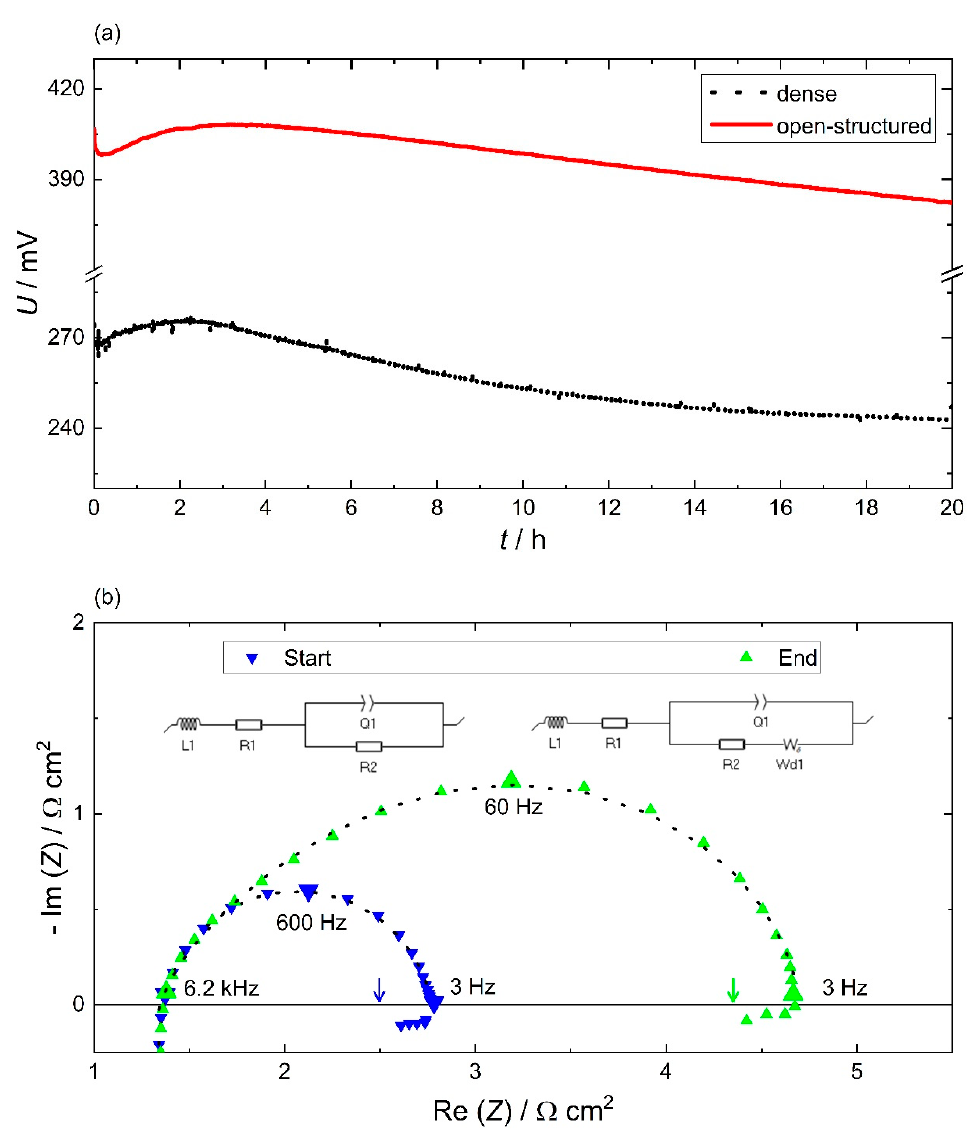
Figure 7. Electrochemical performance stability: ( a ) representative cell voltage under constant current measurement conditions (current density: 60 mA cm − 2 ) under fuel cell operation conditions (513 K, 30 sccm H 2 , 30 sccm O 2 ) over a period of 20 h for the 60 nm dense (black) and open-structured (red) MEAs. Occasional spikes in the cell voltage of the dense MEAs are attributed to water vapor, which improves the electrical connection between the MEA and the sample holder but does not influence the cell performance. ( b ) Potential impedance spectroscopy at 100 mV vs. pseudo-hydrogen electrode pre- (start, marked in blue) and post- (end, marked in green) fuel cell operation (60h @ 60 mA cm − 2 , 0.3 atm H 2 O, 30 sccm H 2 , 30 sccm O 2 ). The black dotted lines represent the fits for the equivalent circuits’ models inserted above the graph. The arrows represent the polarization resistance, which is extracted from the slope of the polarization